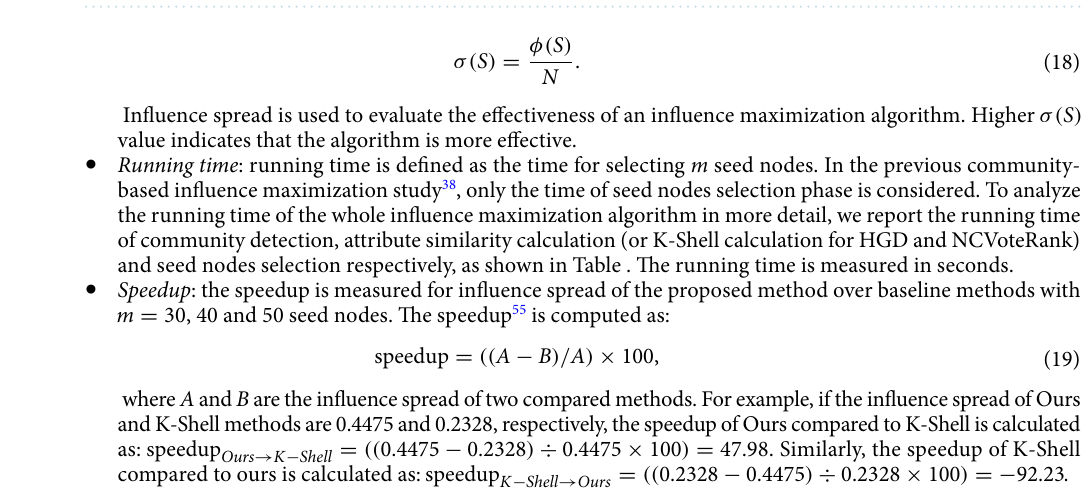
Figure 1. The influence spread σ( S ) of different algorithms on six datasets with different number of initial spreaders m under the proposed LTPlus model. The active threshold of each node is randomly